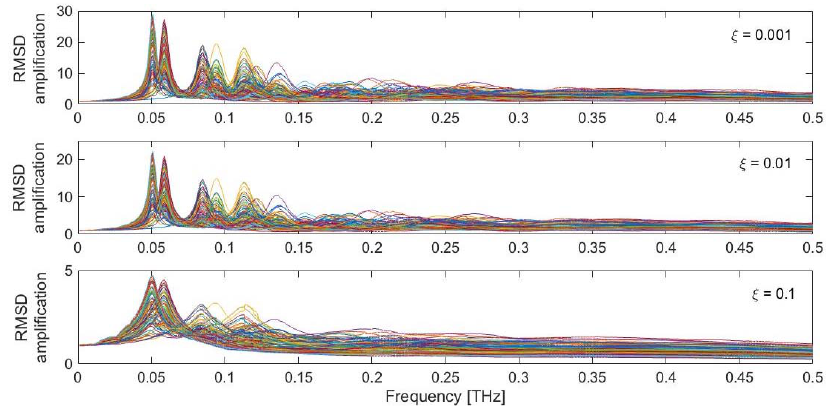
Figure 5. RMSD dynamic amplification for the LAO-binding protein response, as a function of damping ( ξ = 0.001, 0.01, 0.1) and different random force patterns. Each colored curve represents one of the 100 different random force patterns.